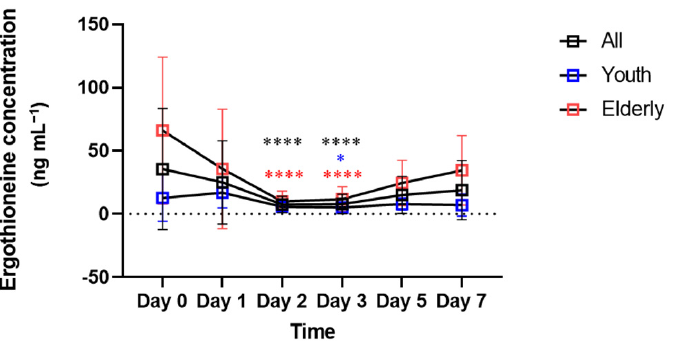
Figure 2. Ergothioneine concentrations in bloodstains over time. Mean and standard deviation are indicated by square and error bars. Black represents the entire subject, blue represents the youth group and red represents the elderly group. To compare the conditions on day 0, which reflects fresh blood, with those on other days, ANOVA or the Friedman test was performed. * p < 0.05 and **** p < 0.0001.